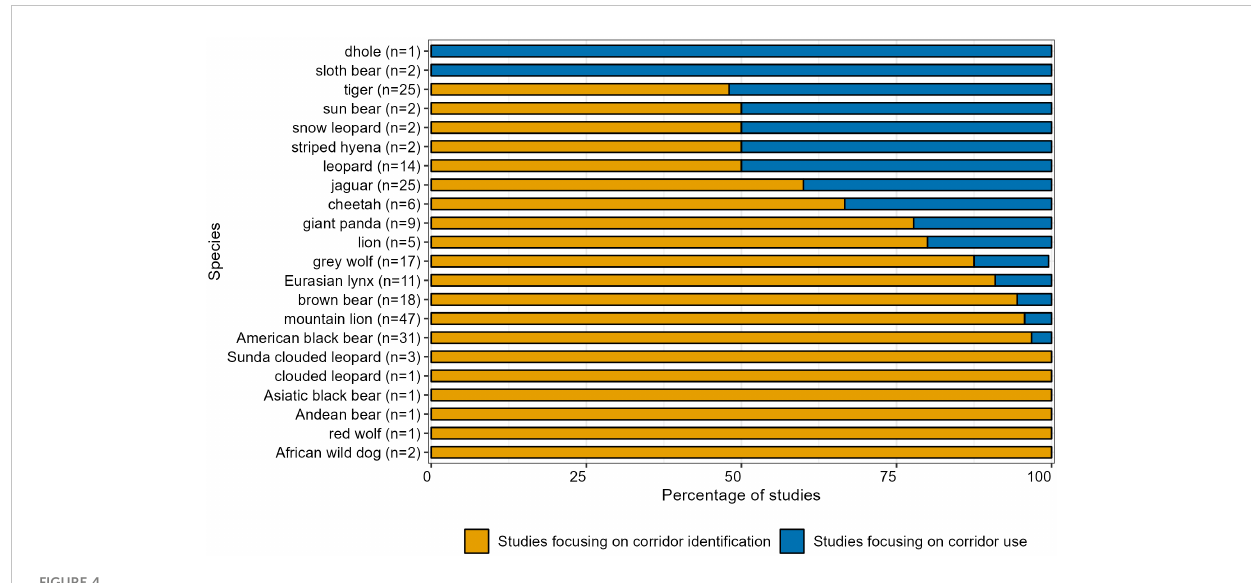
FIGURE 4 Proportion of studies focusing on corridor identi fi cation or use for each